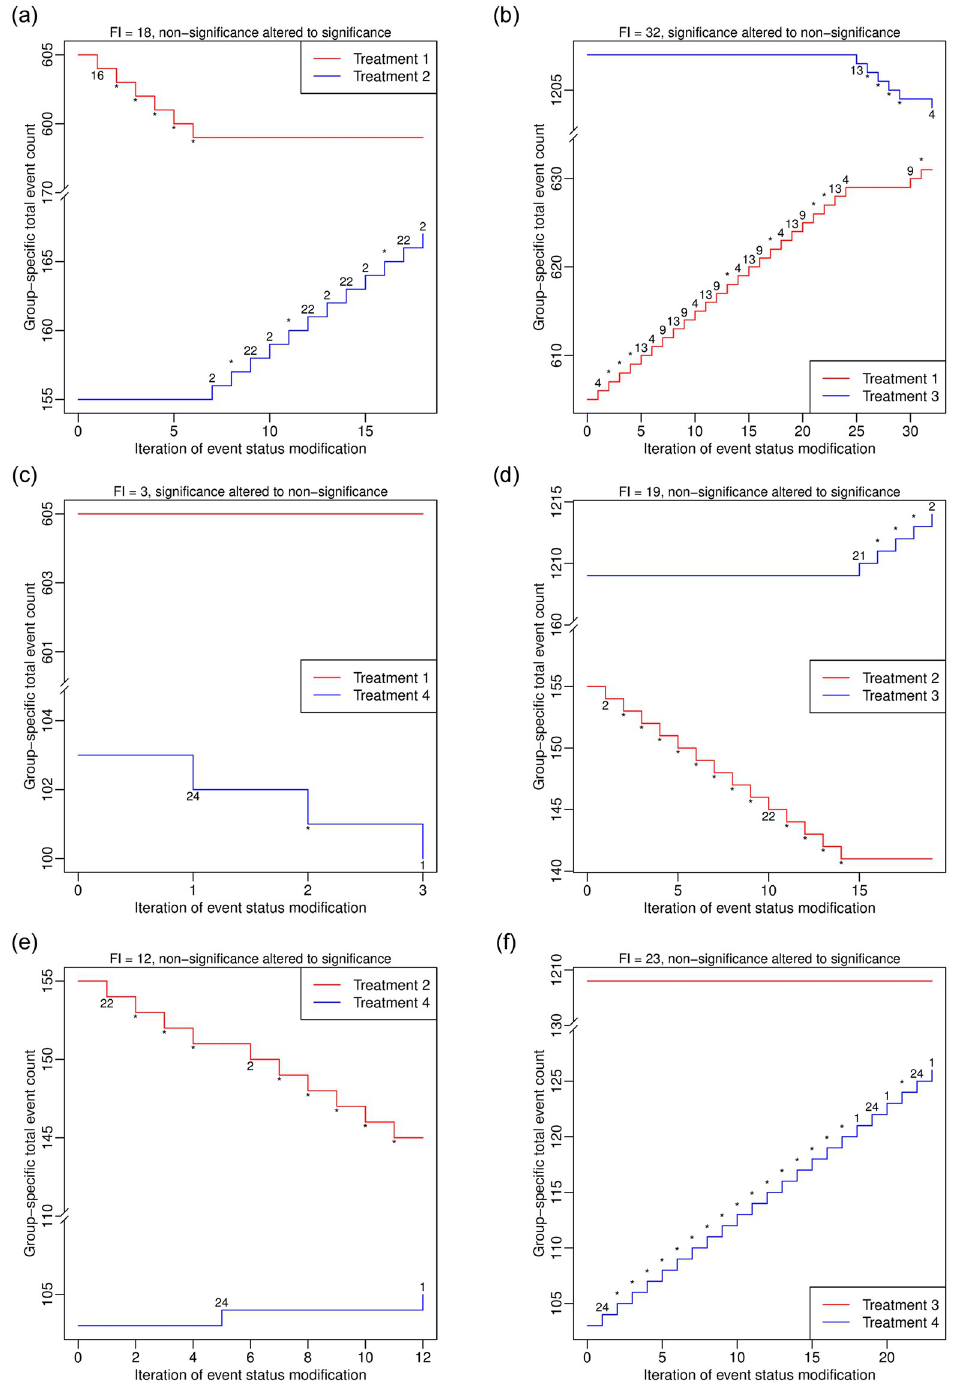
Fig 6. Event status modifications in the network meta-analysis dataset dat.sc . Each line represents changes in the total event count in a certain group. The numbers around each line indicate the studies involved in the event status modifications during the iterations; each asterisk indicates that a study remains unchanged as in the previous iteration. (a) Comparison 2 vs. 1. (b) Comparison 3 vs. 1. (c) Comparison 4 vs. 1. (d) Comparison 3 vs. 2. (e) Comparison 4 vs. 2. (f) Comparison 4 vs.